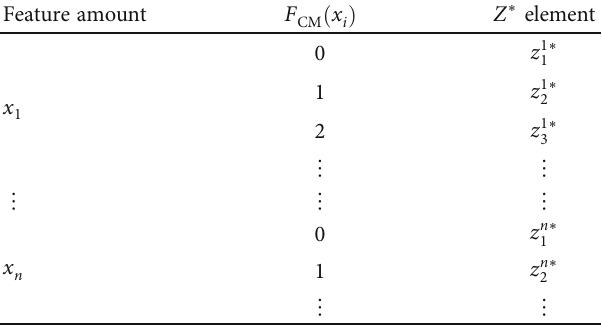
Table 2: Characteristic scale after multivalue discretization.